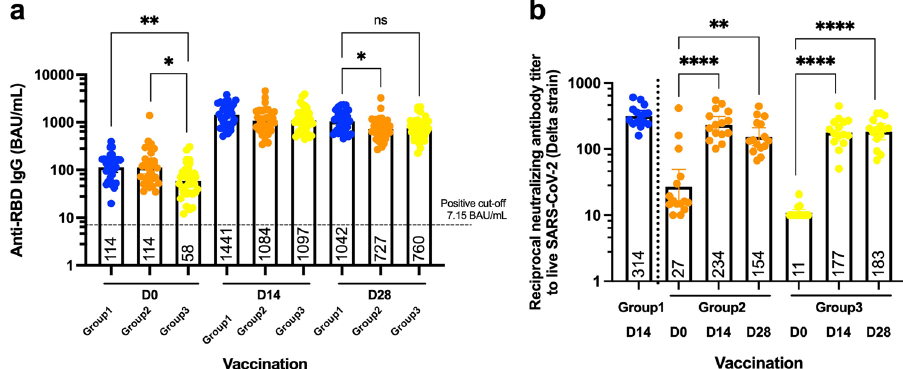
Fig. 4 Antibody responses and neutralising function after boosting. The fractional dose of the viral vector vaccine was delivered intradermally, 4 – 8 weeks (Group2) and 8 – 12 weeks (Group3) after two doses of inactivated SARS-CoV-2 vaccines. Intramuscular viral vector boosting was also given at 4 – 8 weeks after the last vaccination (Group 1). The blood samples were collected before (D0) and after the booster dose for 14, 28 days (D14, D28). a Serum samples were analyzed using CMIA to measure anti-RBD IgG. b Neutralising function of antibodies against the delta variant were tested using PRNT. Each symbol represents one participant, and the number is the geometric mean with 95% CI ( n = 30 – 34 volunteers). Statistical signi fi cance was determined using Kruskal – Wallis test, with Dunn ’ s multiple comparisons test between vaccinated groups (a) and between time points ( b ). * p ≤ 0.05, ** p ≤ 0.01, **** p ≤ 0.0001, ns non signi fi